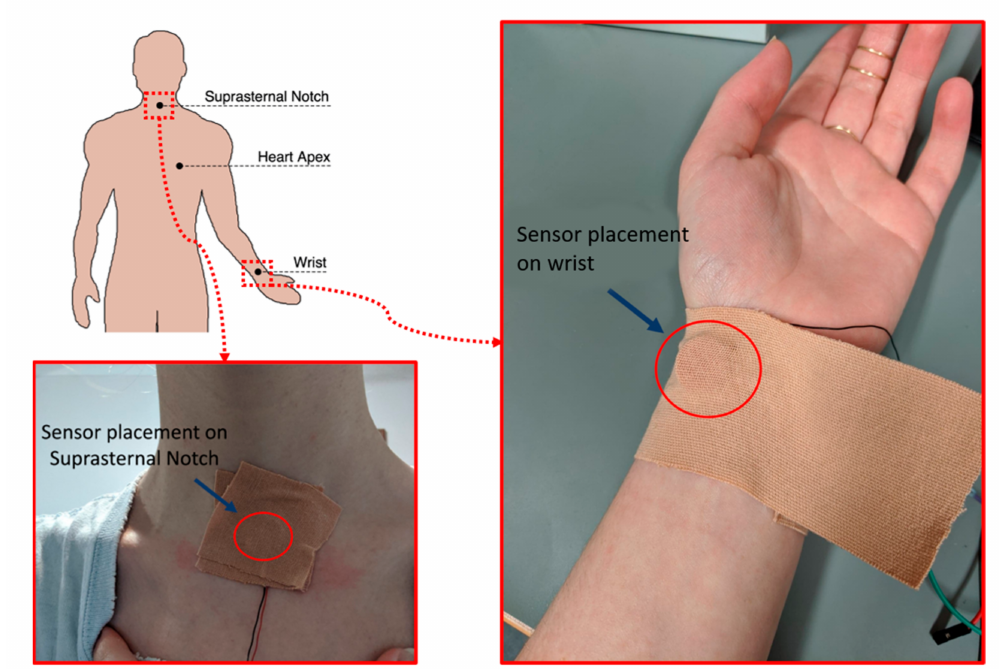
Figure 6. Placement of piezoelectric sensors onto the subject’s body, with details of sensor positioning onto the suprasternal notch and the radial pulse on the